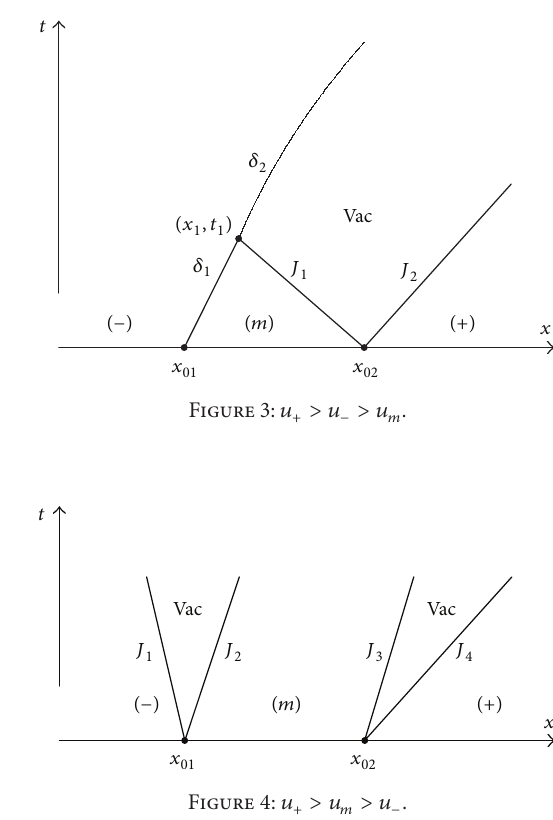
Figure 4: 𝑢 + > 𝑢 𝑚 > 𝑢 −